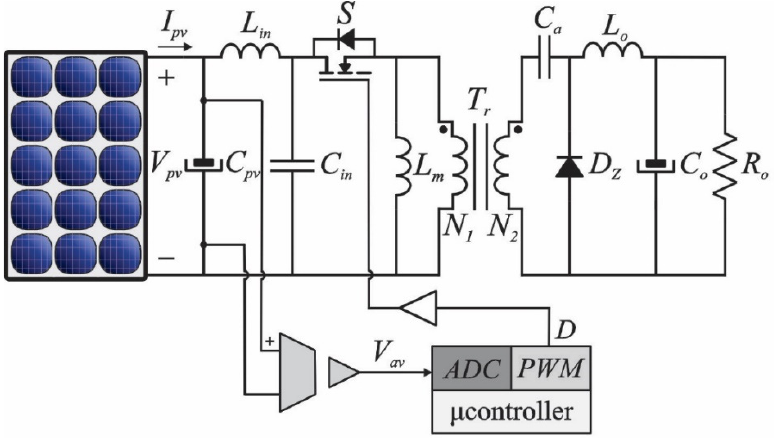
Figure 7. Block diagram of the proposed tracking system employing a Zeta converter as power stage.